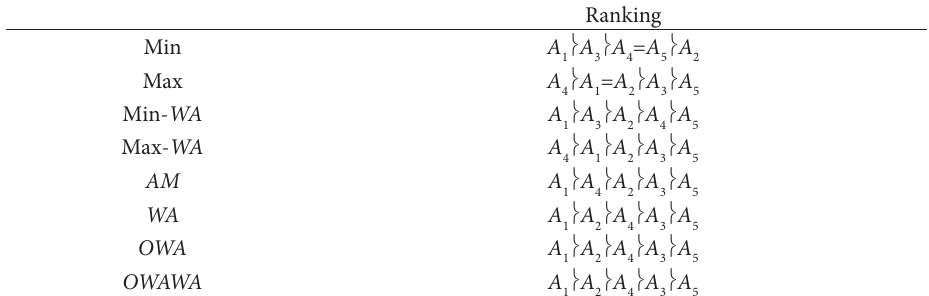
Table 7. Ranking of the policies